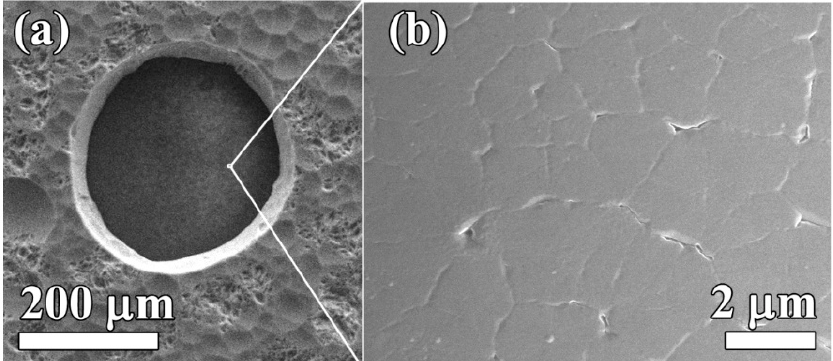
Figure 4. SEM images of a diamond membrane of viewed through a hole in thinned Si substrate ( a ), and the smooth diamond nucleation surface at higher magnification ( b ).